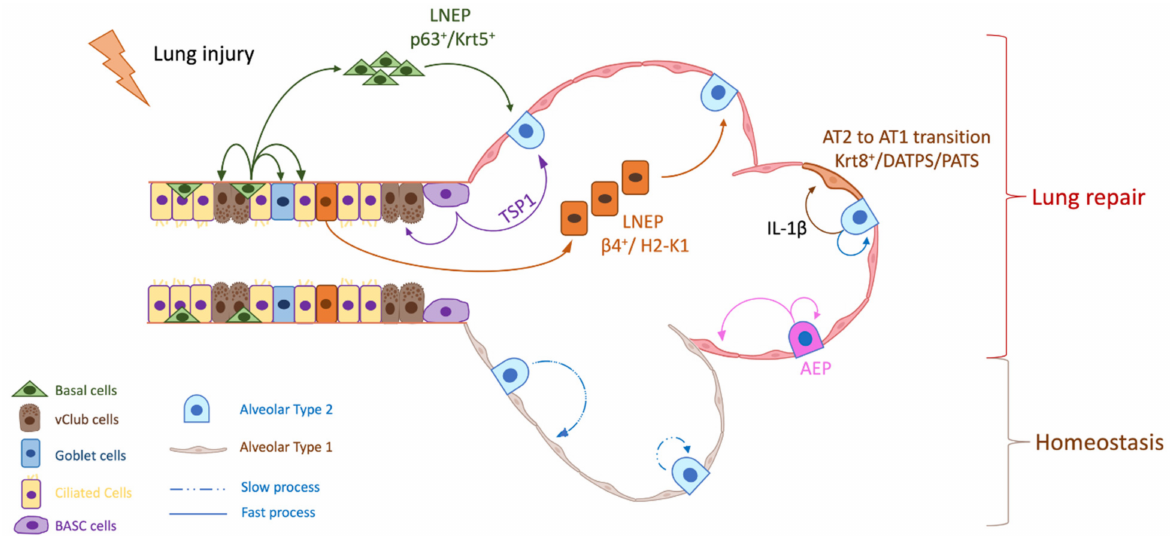
Figure 2. Multiple progenitors are involved in the lung epithelium repair mechanism (Created with BioRender.com, accessed on 15 February 2022). AEP: Alveolar Epithelial Progenitor, AT1: Alveolar Type 1, AT2: Alveolar Type 2, β 4: Integrin Beta 4, DATPS: Damage-Associated Transient Progenitors, IL-1 β : Interleukin 1 Beta, Krt5: Keratin 5, Krt8: Keratin 8, LNEP: Lineage-Negative